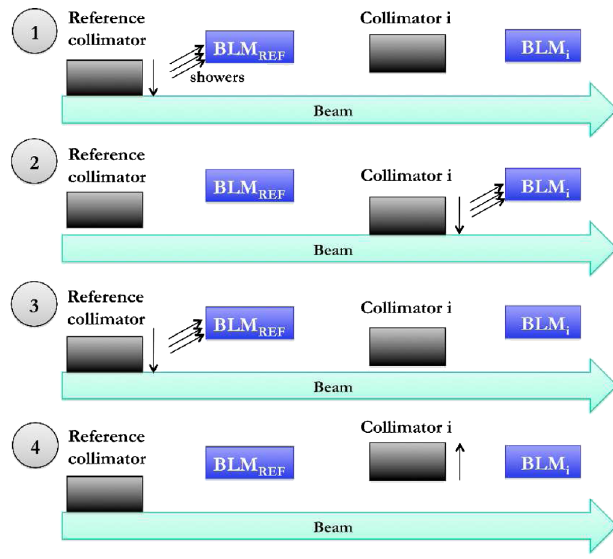
FIG. 4. The four-stage beam-based alignment procedure for collimator i . The reference collimator is aligned to form a reference cut in the beam halo (1). Collimator i is aligned (2), followed by a realignment of the reference collimator (3). Finally, collimator i is opened to its position in the hierarchy